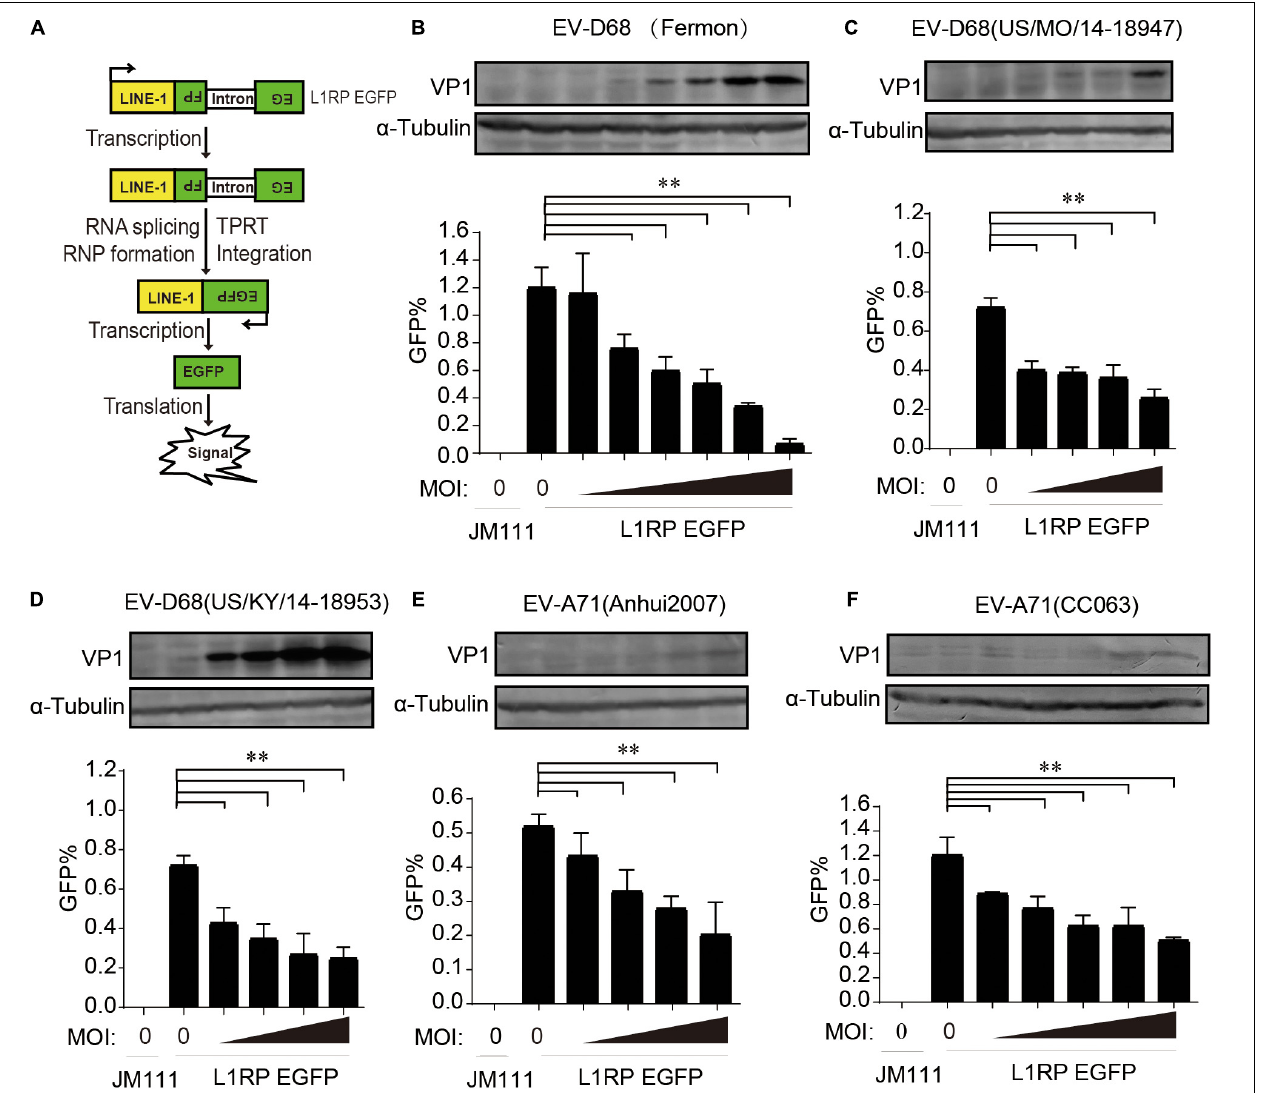
FIGURE 1 | Suppression of long interspersed element 1 (LINE-1) retrotransposition by both EV-D68 and EV-A71. (A) Retrotransposition assay process. EGFP can only be detected when LINE-1 successfully transposes into the genome and the intron is removed during RNA splicing. (B–D) L1RP EGFP plasmids were transfected into HEK293T cells. Cells were then infected with EV-D68 (Fermon) at increasing MOI of 0, 2 × 10 − 5 , 5 × 10 − 5 , 1 × 10 − 4 , 2 × 10 − 4 , 5 × 10 − 4 , and 1 × 10 − 3 or EV-D68(US/MO/14-18947)/EV-D68(US/KY/14-18953) at increasing MOI of 0, 2 × 10 − 5 , 5 × 10 − 5 , 1 × 10 − 4 , and 2 × 10 − 4 12 h post-transfection. Retrotransposition-defective LINE-1 (JM111) was used as a negative control. 4 days after transfection, flow cytometry assay was performed to determine EGFP-positive cells. The bar graph of EGFP-positive cells represents retrotransposition efficiency. The asterisks indicate statistically significant differences between groups by Unpaired Student’s t -test ( p < 0.01). After flowcytometry assay, the cells were harvested, lysed and immunoblotted by anti-EV-D68 VP1 antibody and anti- α -Tubulin antibody. (E,F) HEK293T cells were transfected with L1RP EGFP plasmids and then infected with EV-A71(Anhui2007) at increasing MOI of 0, 2 × 10 − 4 , 5 × 10 − 4 , 1 × 10 − 3 , and 2 × 10 − 3 or EV-A71(CC063) at increasing MOI of 0, 1 × 10 − 3 , 2 × 10 − 3 , 5 × 10 − 3 , 1 × 10 − 2 , and 2 × 10 − 2 12 h post-transfection. JM111 was used as a negative control. Flow cytometry assay was performed to determine EGFP-positive cells. The bar graph of EGFP-positive cell fraction represents retrotransposition efficiency. The asterisks indicate statistically significant differences between groups by Unpaired Student’s t -test ( p < 0.01). After flowcytometry assay, the cells were harvested, lysed and immunoblotted by anti-EV-A71 VP1 antibody and anti- α -Tubulin antibody. All experiments in this figure were performed in triplicate, and each error bar indicates the SD of three replicates in one experiment.